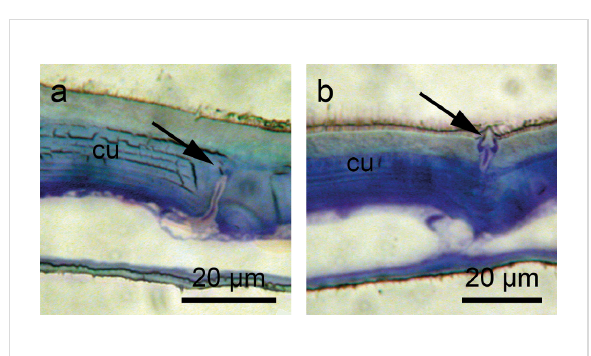
Figure 5: Toluidine blue/borax stained semi-thin sections through the clavus of a hemelytron of N. glauca (dorsal surface is up). Arrows mark mechanoreceptors. a) Lower part of a dendritic canal running through the cuticle with an inner dendrite. b) Socket region of the seta with outer dendritic tip at its base. cu =